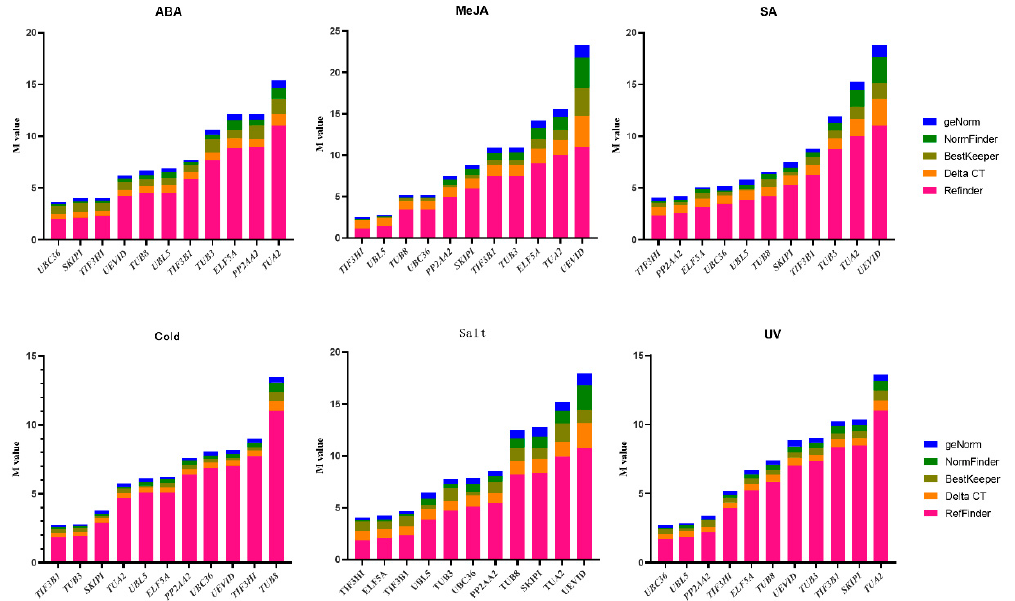
Figure 3. Gene expression stability stacking diagram ranked by five types of analysis methodology under individual experimental conditions. The top three figures are the expression stability ranking of each candidate internal reference gene under hormone treatment, and the bottom is abiotic stress.